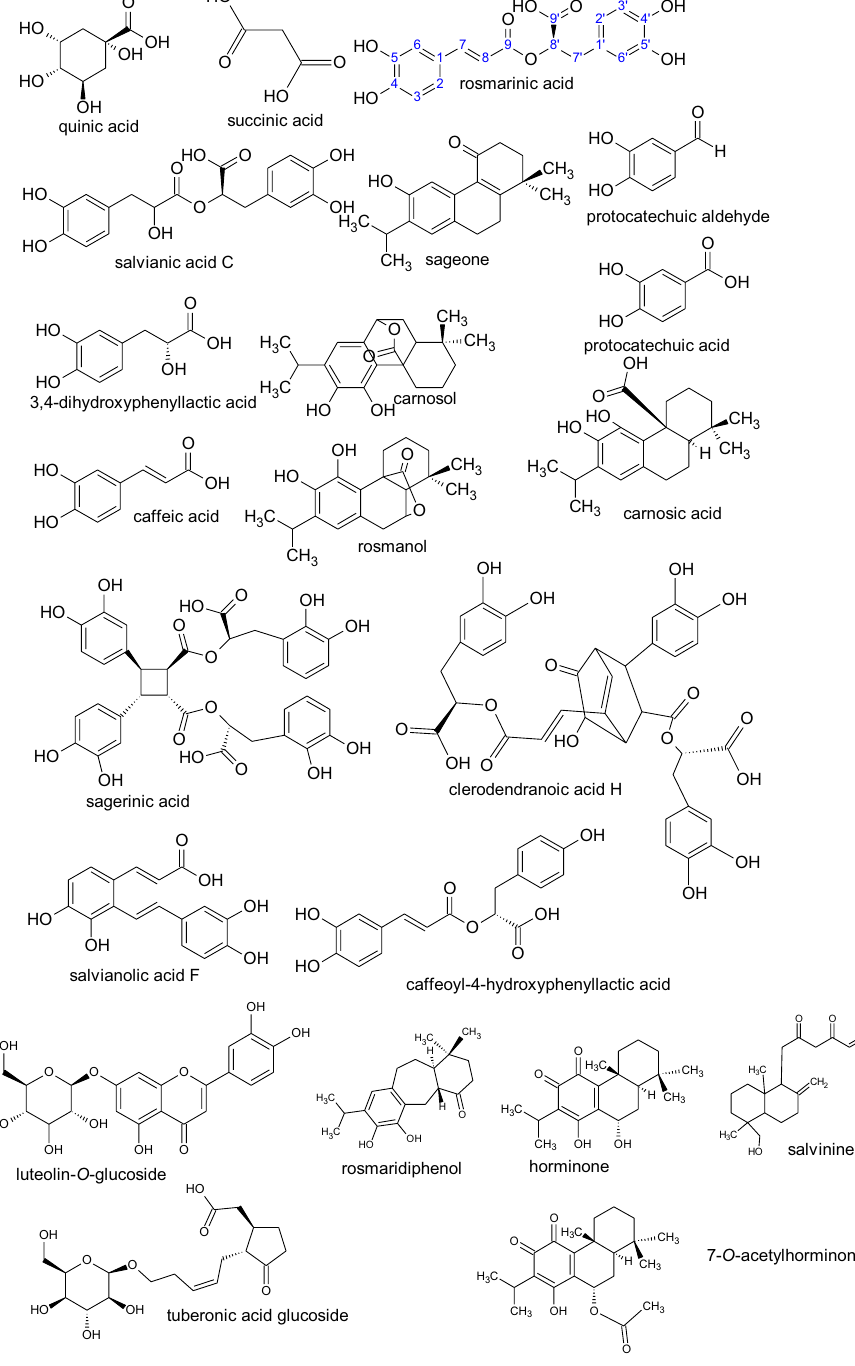
Figure 1. Detected compounds in Lepechinia meyenii (Walp.) Epling and Lepechinia floribunda (Benth.)